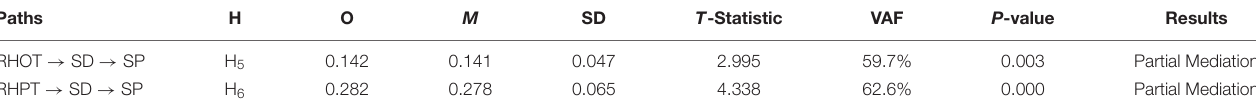
TABLE 6 | Indirect effects. Paths